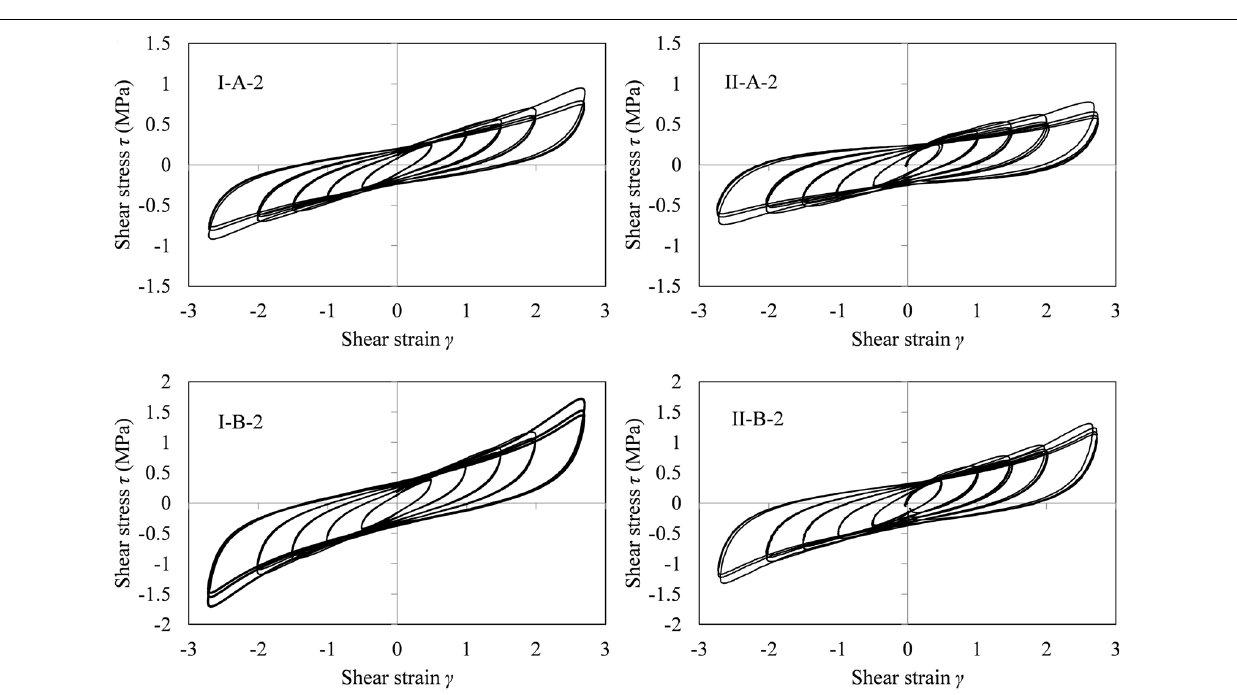
Frontiers in Built Environment |